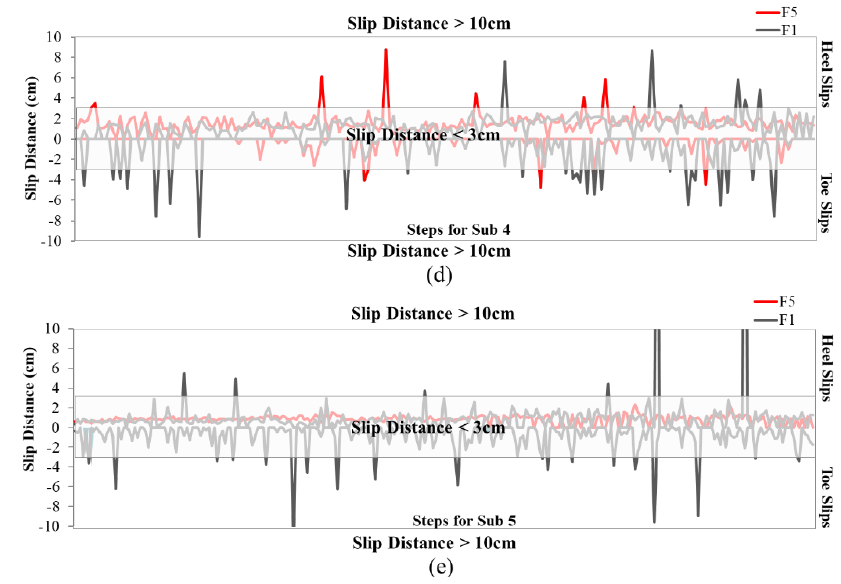
Figure 14. The slips distance for both heel and toe slips across all steps taken by ( a ) Sub 1, ( b ) Sub2, ( c ) Sub 3, ( d ) Sub 4, and ( e ) Sub 5.